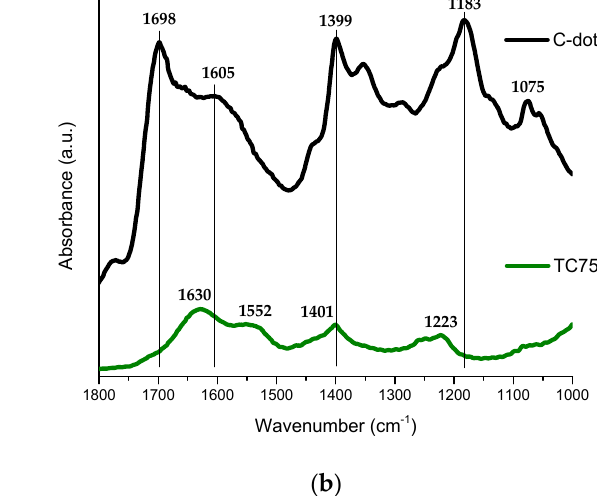
( b ) Figure 7. ( a ) UV-Vis/NIR diffuse reflectance spectra and ( b ) Tauc plots for TiO 2 (TC0), TC25, TC50 and TC75 photocatalysts.